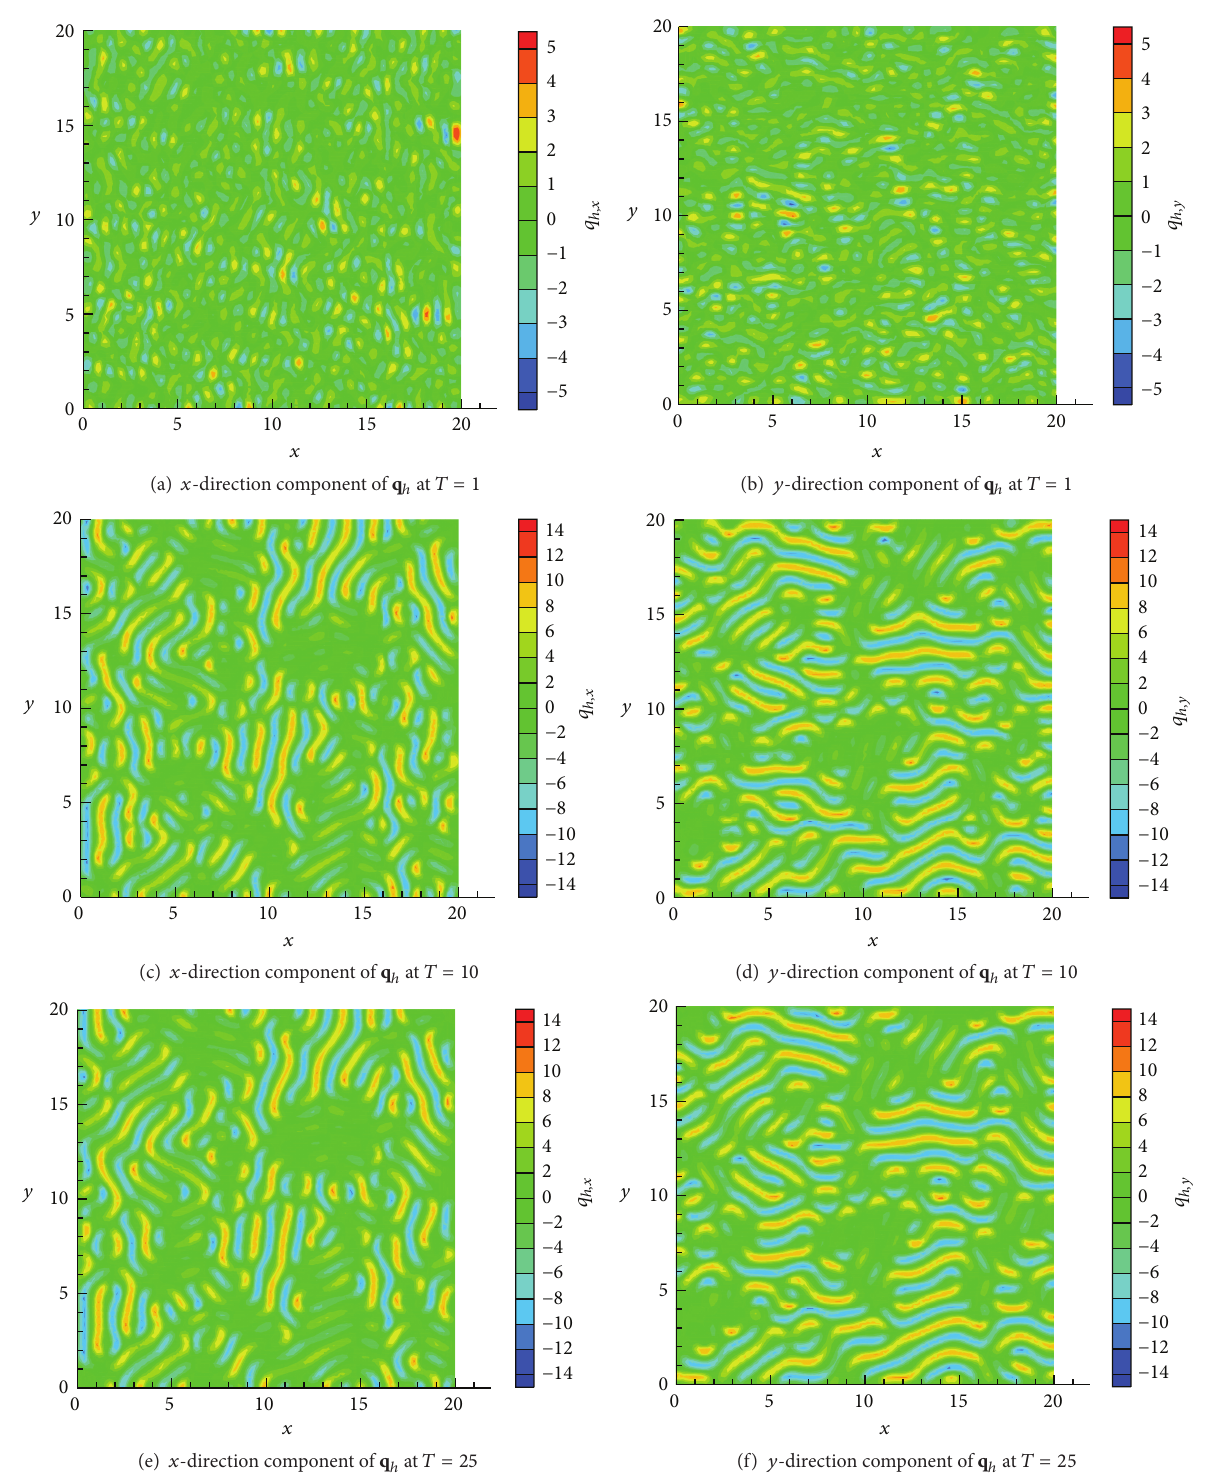
Figure 8: The time evolution of numerical approximates for fluxes q on the square domain with 𝑏 12 = 32